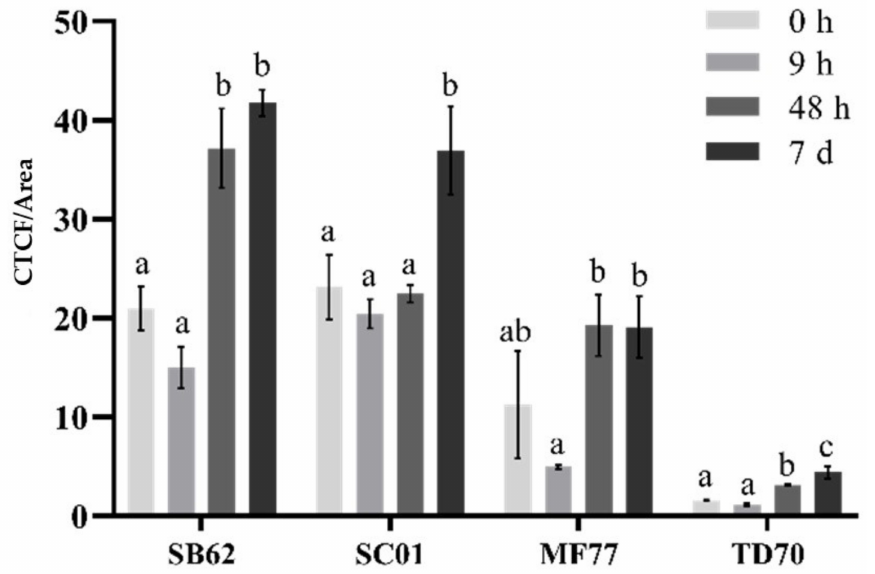
Figure 1. Corrected total cell fluorescence (CTCF) normalized by cell size, for samples of SB62, SC01, MF77 and TD70 collected at 0 h, 9 h, 48 h and 7 days (d) after inoculation into enrichment medium, and stained with FITC-ConA before fluorescence imaging. The data points shown are means for two biological staining repeats, calculated from the means of two technical repeats, derived from the means of five images, from which the mean CTCF/area for each cell captured was used. The error bars indicate standard deviation between biological repeats. Different letters indicate significant differences ( p < 0.05) between samples collected at different times within each separate species as analyzed by one-way ANOVA and the Fisher’s LSD